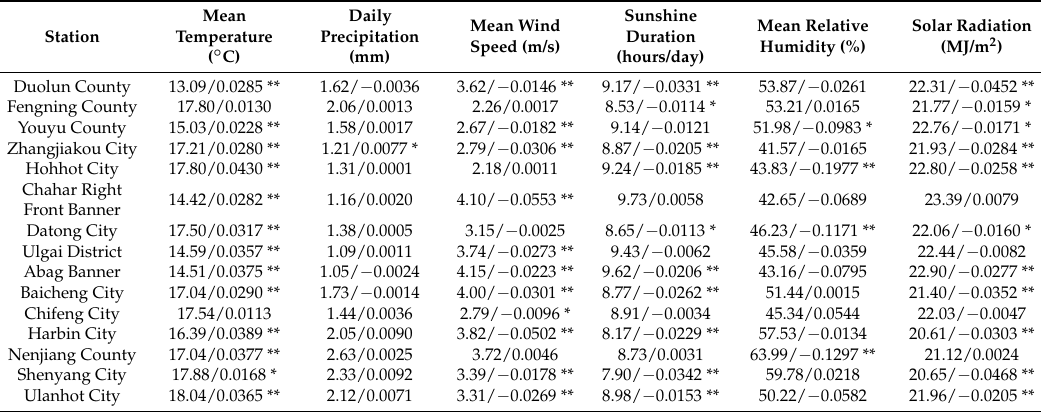
Table 3. Variations in climatic factors during the oat growth period at 15 stations from 1960 to 2015 (annual average/slope